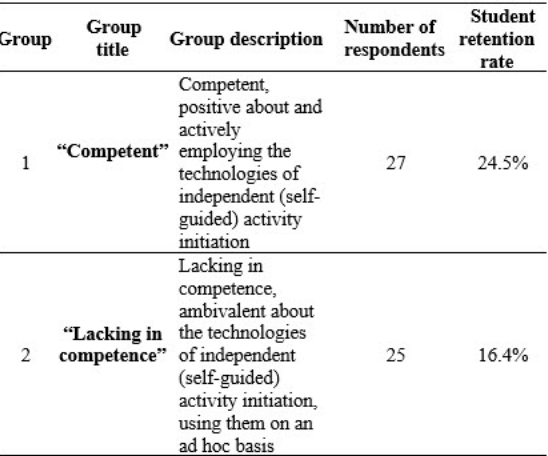
Table 2. Groups of distance learning teachers set up according to the teachers’ at- titude to the technologies of independent (self- guided) activity